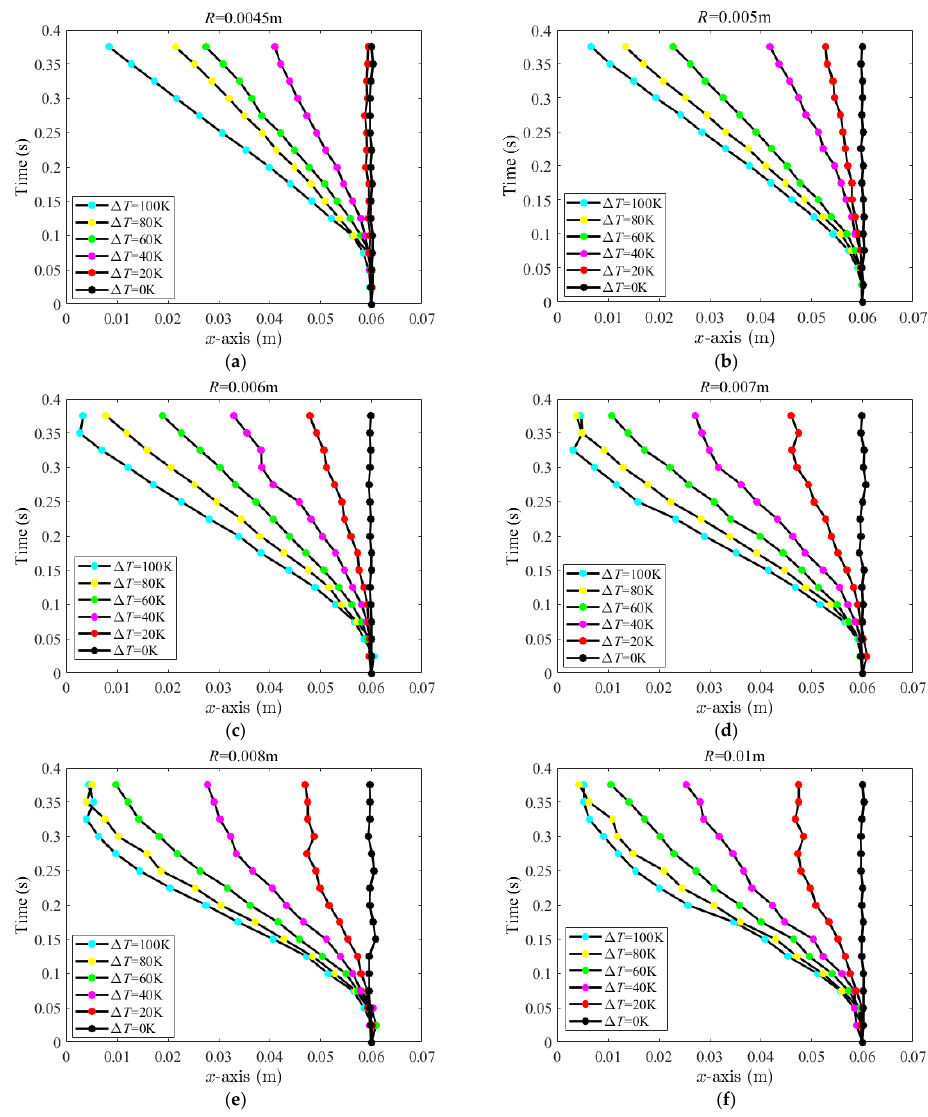
Figure 8. Schematic representation of the movement of the centroid positions of bubbles in the x - direction with different bubble radii, ( a ) R = 0.0045 m, ( b ) R = 0.005 m, ( c ) R = 0.006 m, ( d ) R = 0.007 m, ( e ) R = 0.008 m and ( f ) R = 0.01 m.